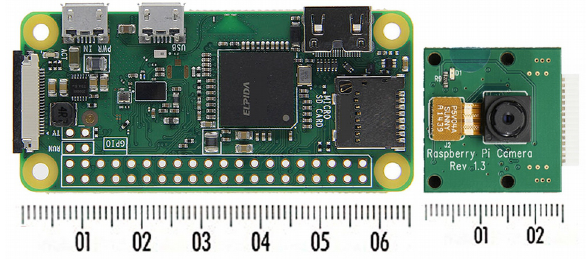
Figure 1. Raspberry Pi Zero W and camera module